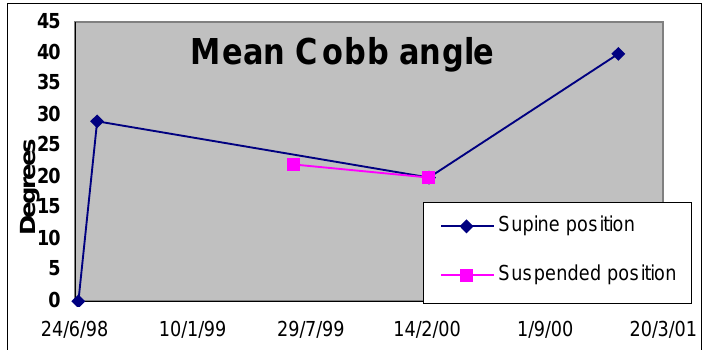
Graph 1. Development of scoliosis according to consecutive